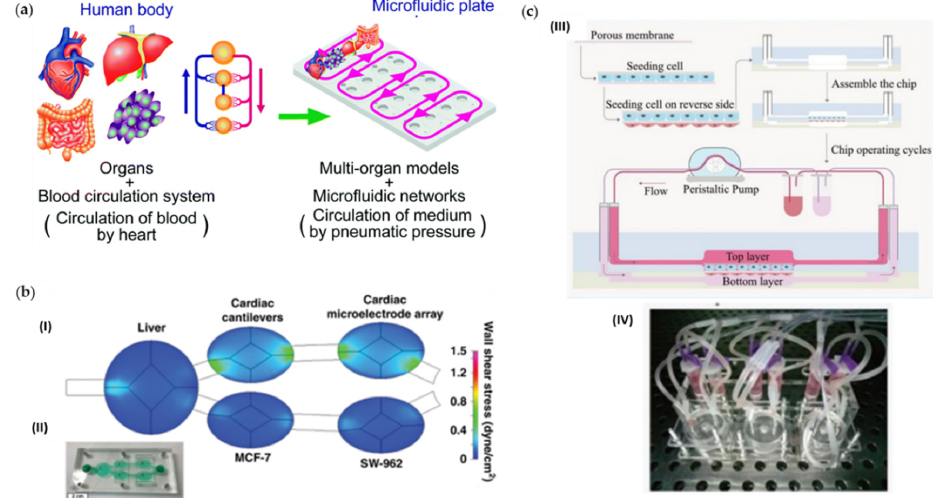
Figure 8. Multi-organ systems. ( a ) Concept of a multi-throughput multi-organ-on-a-plate system and the culture devices in the assembled state and with the lid removed fabricated by Satoh et al. [82]. Adapted from [83]. ( b ) Five-chamber multi-organ system platform used by McAleer et al. [84] to evaluate the efficacy and off-target toxicity of anticancer drugs: (I) Computational fluid dynamics modeling and (II) the fabricated microfluidic system. Adapted with permission from [83]. ( c ) Illus- tration of the chip assembly and operation developed by Liu et al. [85]: (III) Cells were sequentially seeded on the front and back of the porous membrane prior to chip assembling; (IV) Picture of the entire system of the chip devices operated by a peristaltic pump. Adapted with permission from